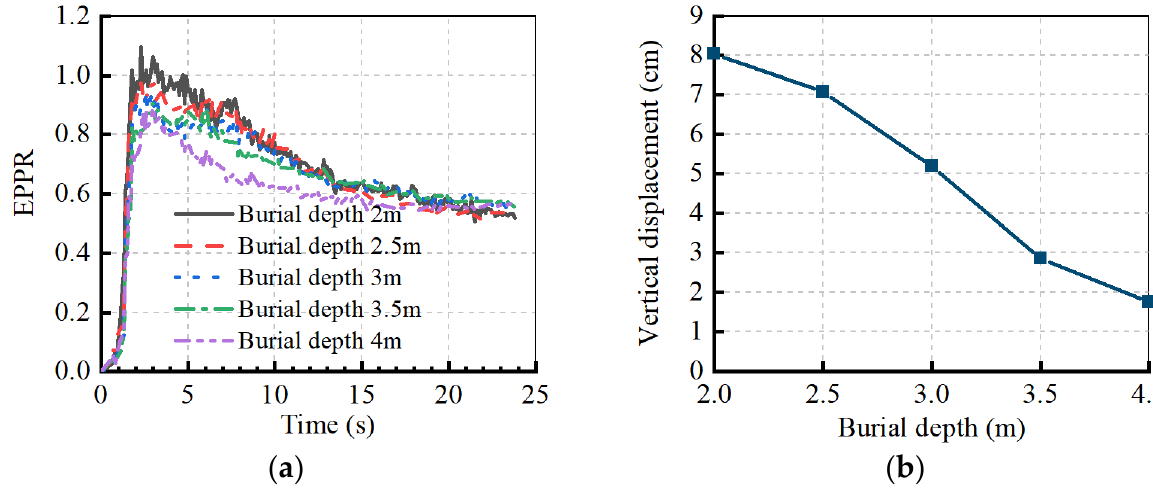
Figure 16. Five burial depth conditions: ( a ) time histories of excess pore water pressure in the soils beneath the structure, and ( b ) vertical displacement at the midpoint of the top slab.